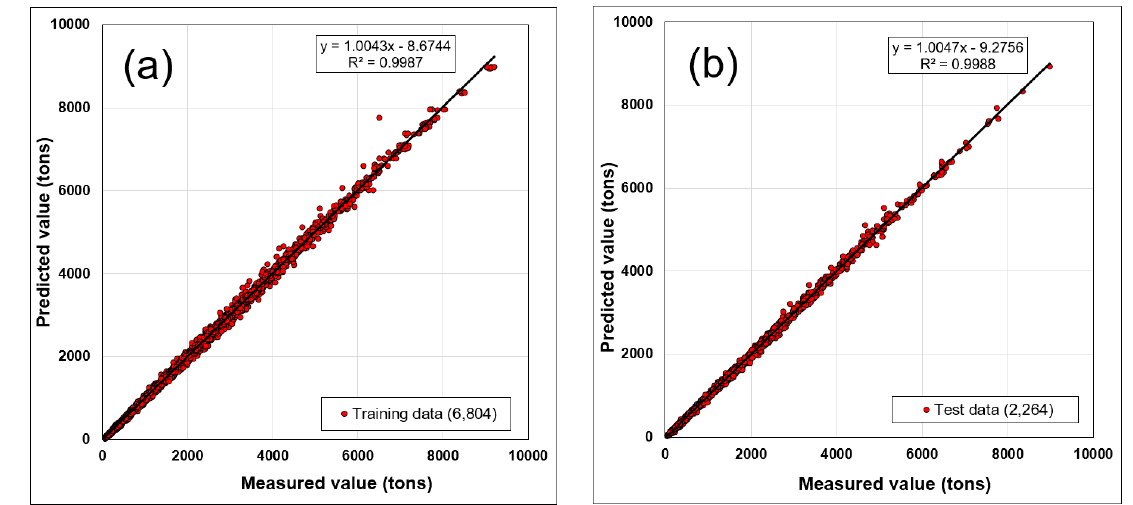
Figure 7. Results of correlation analysis between measured and predicted ore production (tons) using optimal DNN model with five hidden layers and 40 hidden layer nodes: ( a ) training data and ( b ) test data.